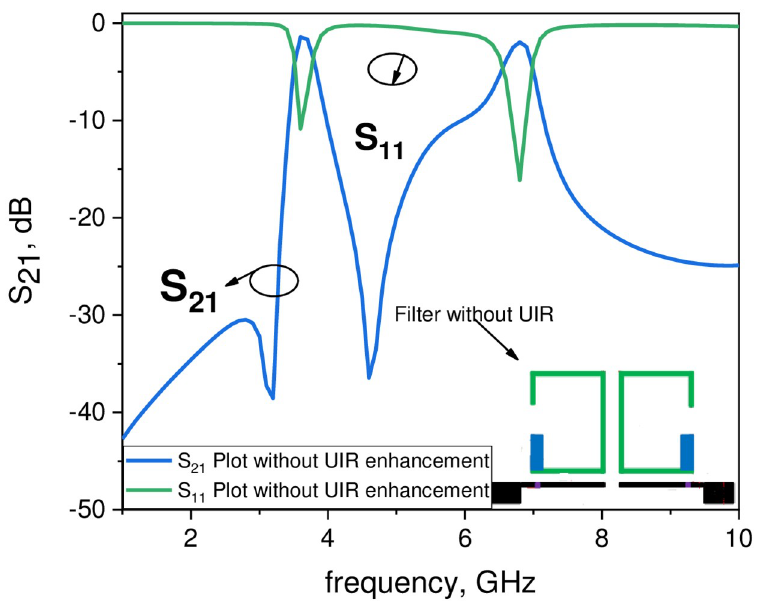
Fig 9. Frequency plots of the filter without uniform impedance resonator